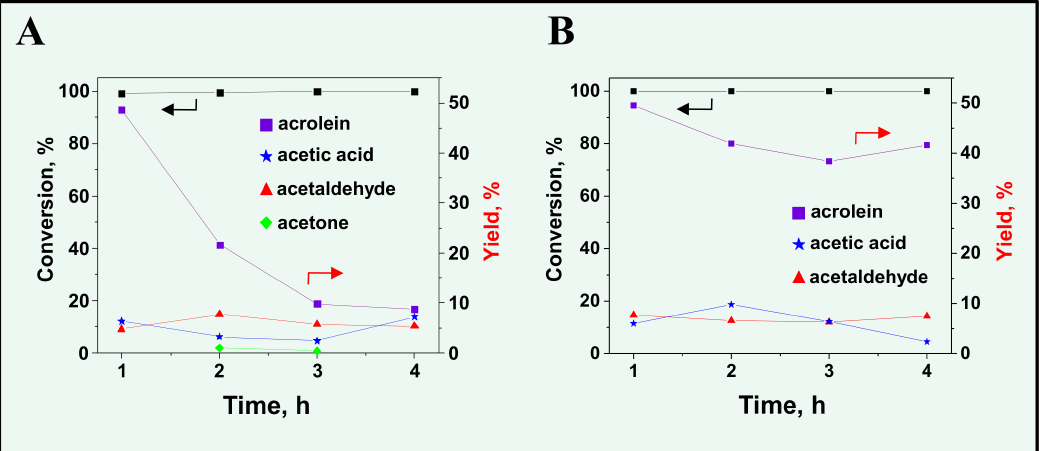
Figure 5. Conversion of glycerol and yield of acrolein in the oxidative dehydration of glycerol on a dual catalytic system: ( A ) TPS/SBA-15-10 + V/SBA-15; ( B ) Nb/SBA-15 +